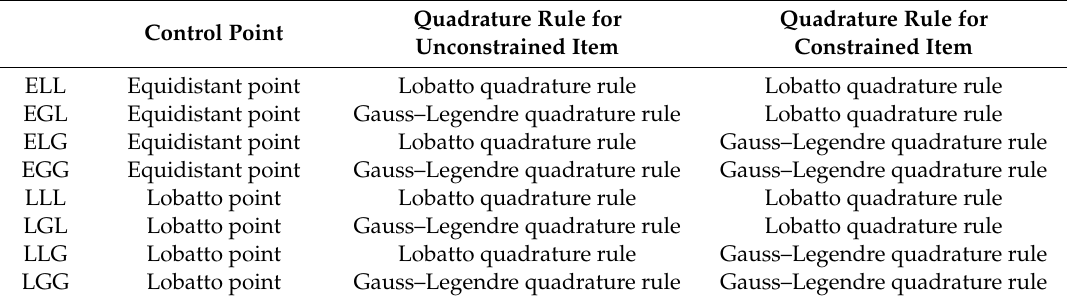
Table 2. Eight algorithms and their corresponding control points and quadrature